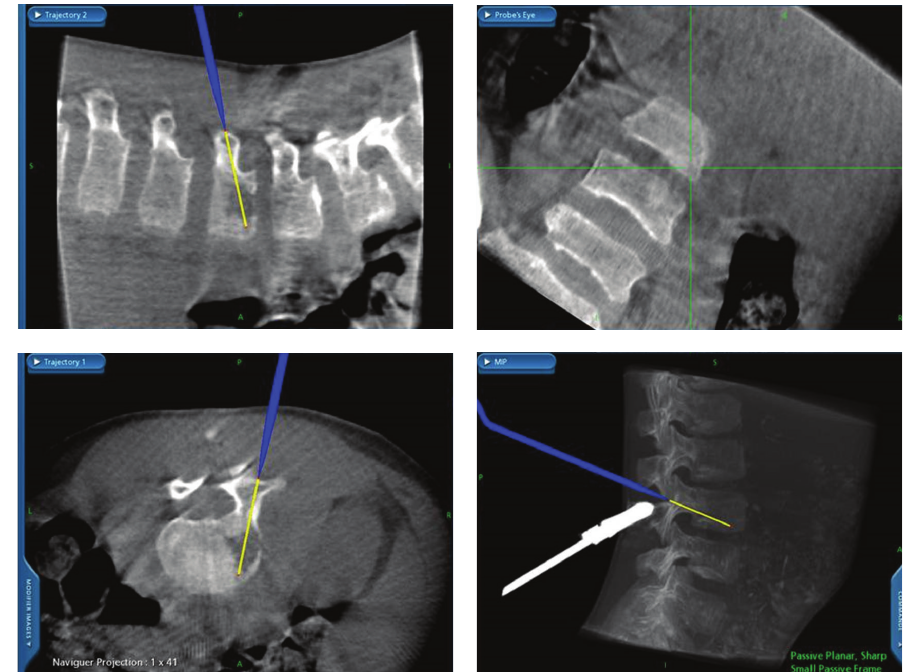
Figure 3: Image during CT-guided aspiration